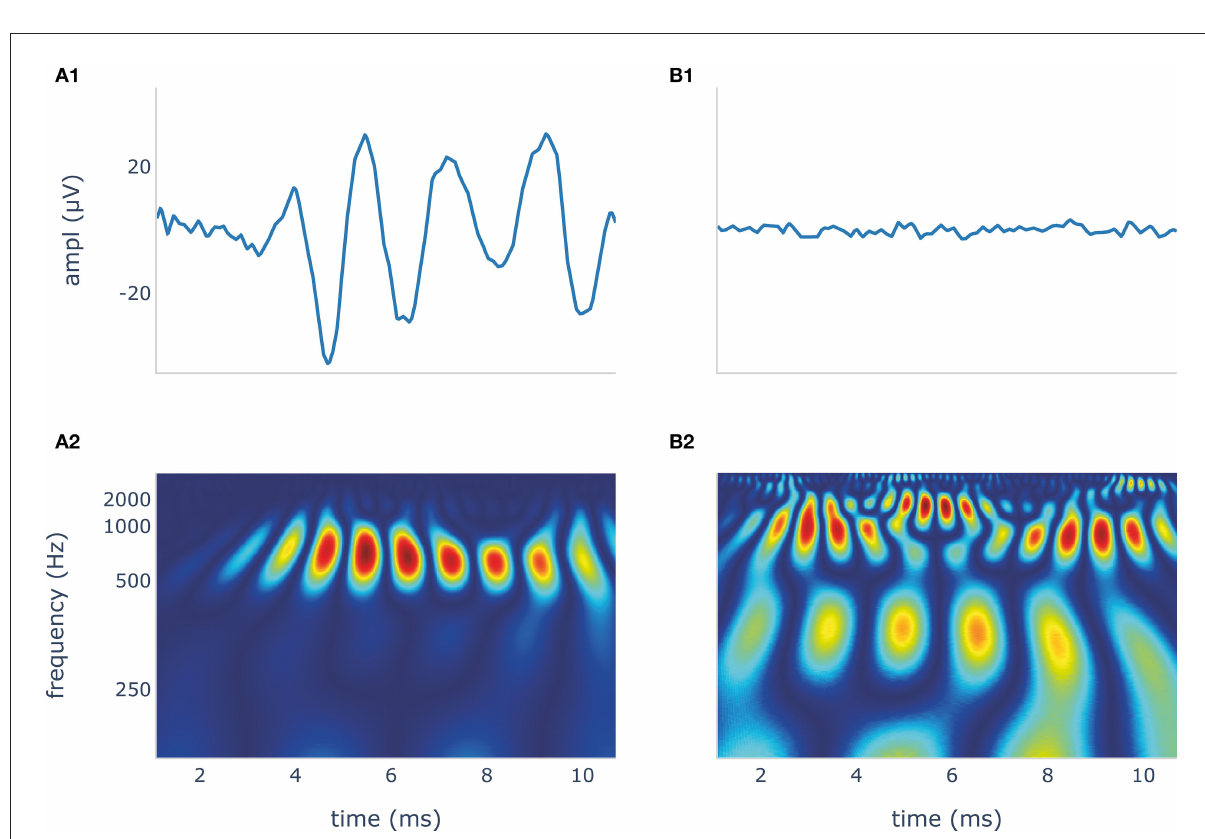
FIGURE3 The blue DIF curves (A1,B1) show a recognizable CM/DIF signal (A1) and noise with no visible CM/DIF component (B1) , respectively, in response to a 500 Hz stimulus. Their corresponding time frequency scalograms generated using continuous wavelet transformation (CWT) are shown in (A2,B2) . These scalograms were then used to train and test the deep learning algorithm. DIF, difference; CM, cochlear microphonic.